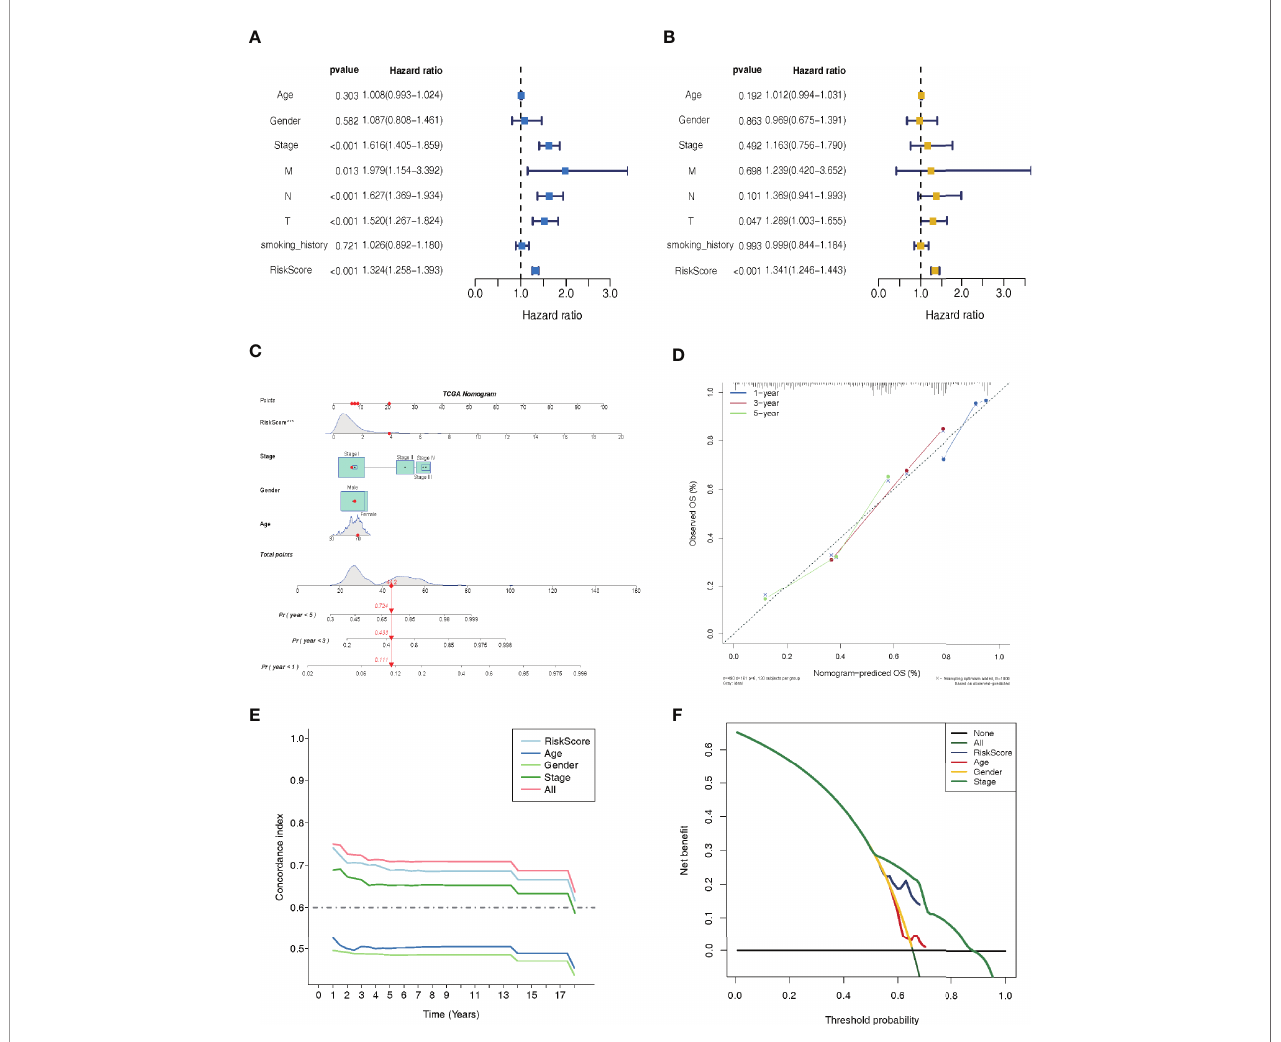
FIGURE 4 | Lactate metabolism-related (LMR)-lncRNA signature for the training cohort as an independent predictive predictor with potential therapeutic signi fi cance. Cox regression analysis using univariate (A) and multivariate (B) variables to anticipate survival of patients using the LMR-lncRNA signature. (C) A nomogram based on clinical characteristics (e.g., the risk score) and patient survival. (D) The calibration chart to determine the consistency of the anticipated and actual 1-, 3-, and 5- year survival rates. (E) The concordance index (C-index) was determined. (F) Decision curve analysis (DCA) of the nomogram prediction model and the TNM staging